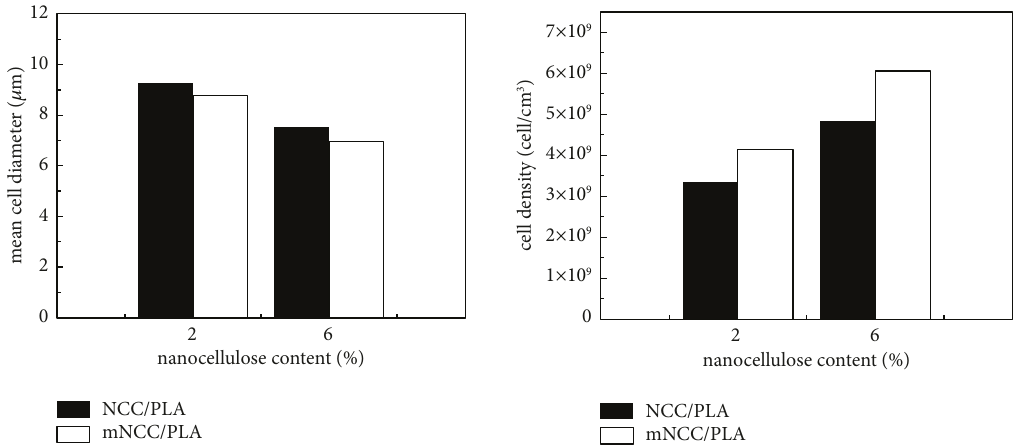
Figure 13: Average cell diameter and cell density (110 ° C, 18MPa, 2 h of PLA foaming